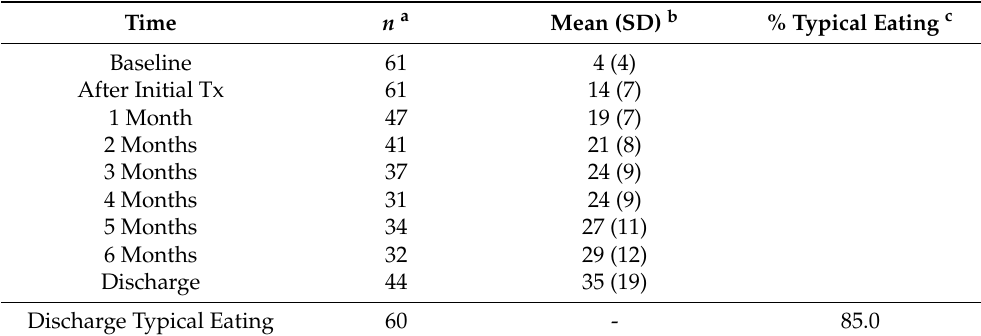
Table 5. Food Selective—Number of Foods